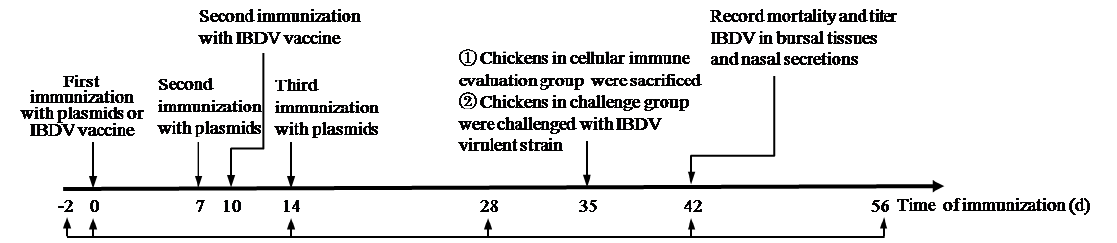
Figure 1. Time line of immunization.